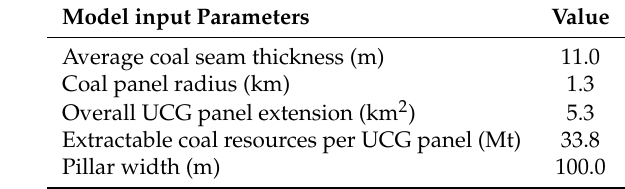
Table 5. Boundary conditions for the radial offshore UCG well design in the reference scenario